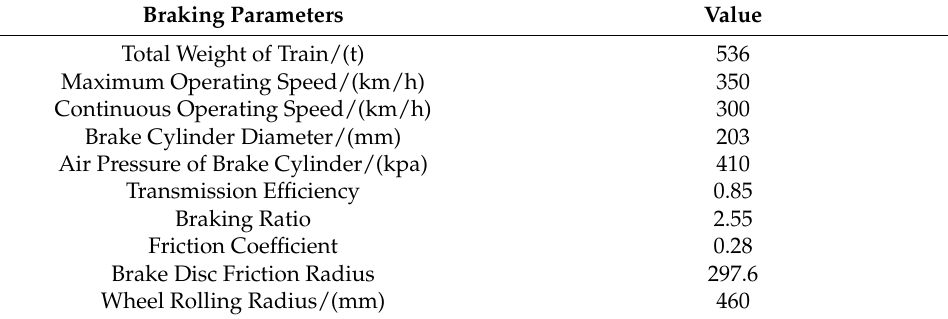
Table 1. Braking parameters of CRH3.